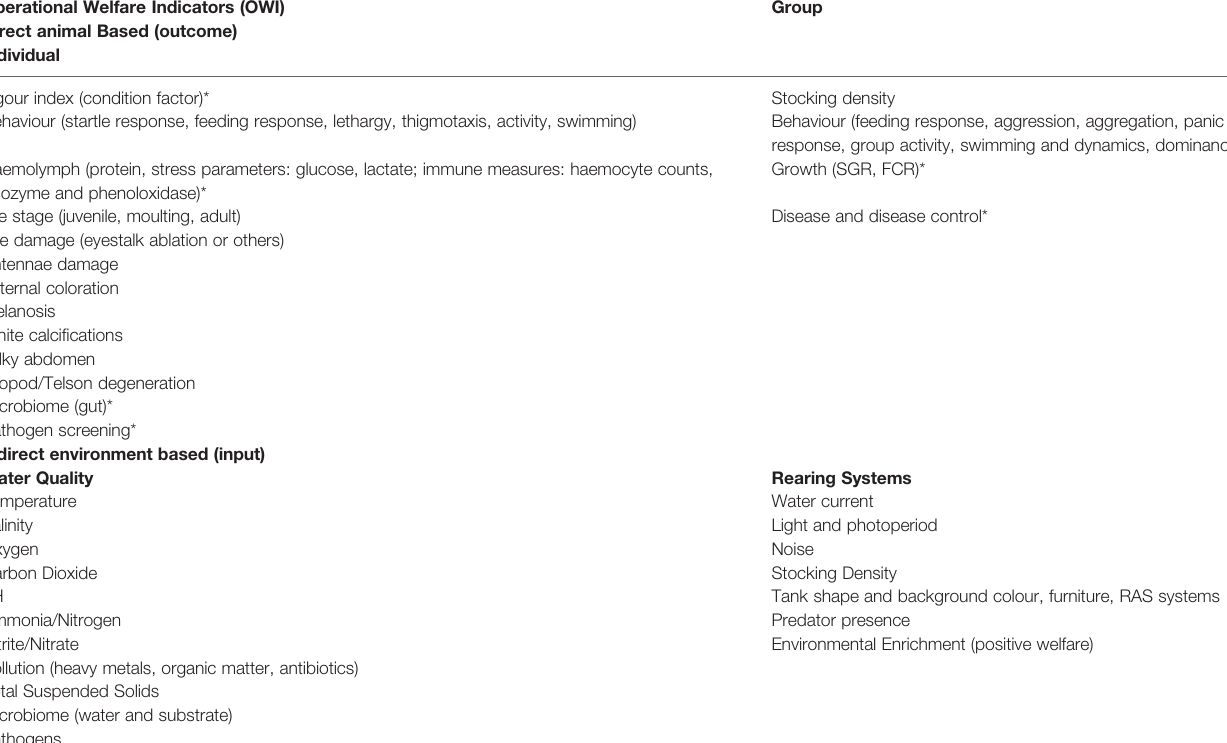
TABLE 4 | List of potential OWIs to be measured for welfare assessment and their use as a decision support method. Invasive OWIs are highlighted using an asterisk (*). Operational Welfare Indicators